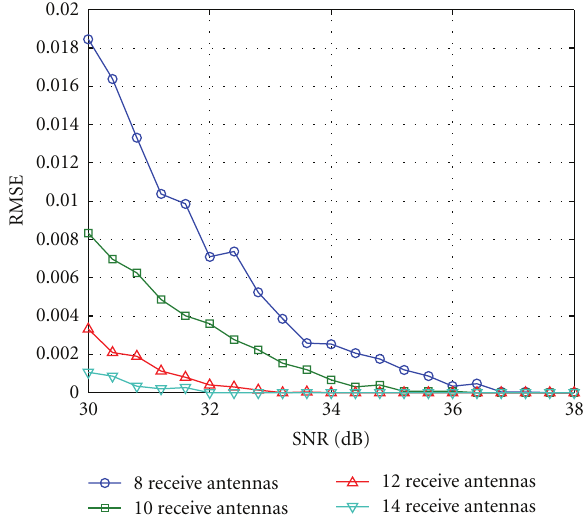
Figure 5: The DOA estimation performance with di ff erent ele- ments of receive array.